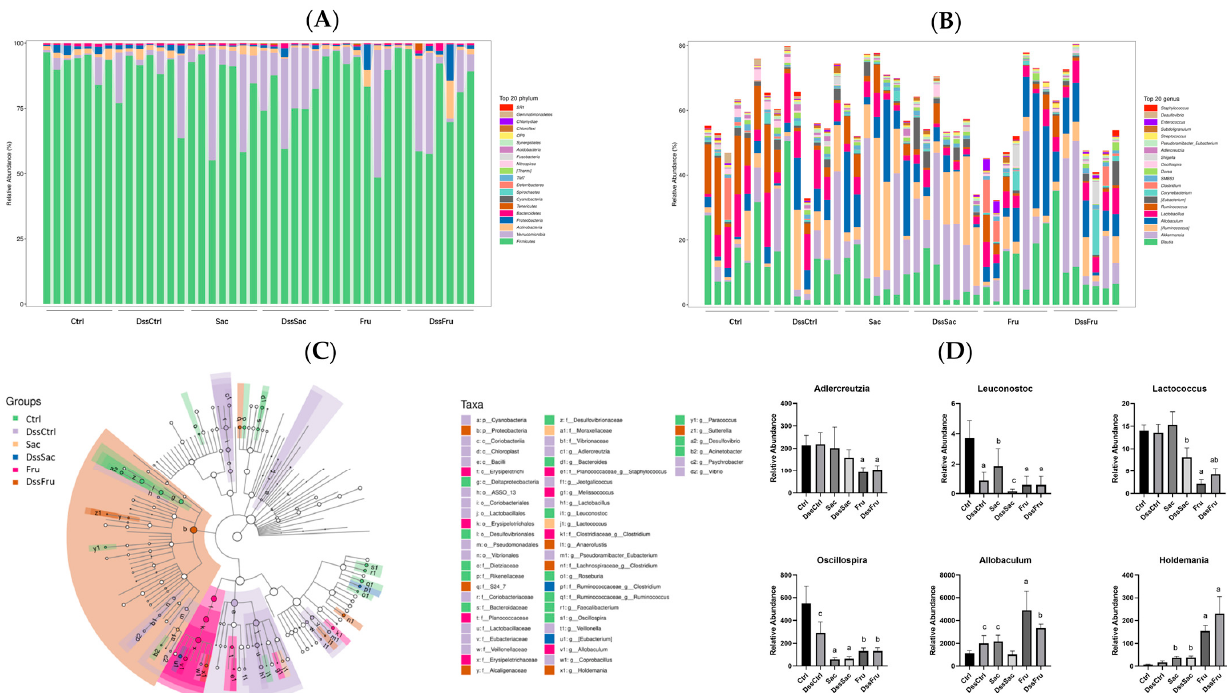
Figure 4. Alteration of sucrose and fructose on gut bacterial community in rats ( n = 7). ( A , B ) Relative abundance of the fecal microbiota at the phylum and genus level. ( C ) Cladogram of different groups (LDA ˃ 2). ( D ) Presentative differential taxa, n = 7. Data represent the following: means ± SEM; different letters indicate significant difference, p ˂ 0.05.